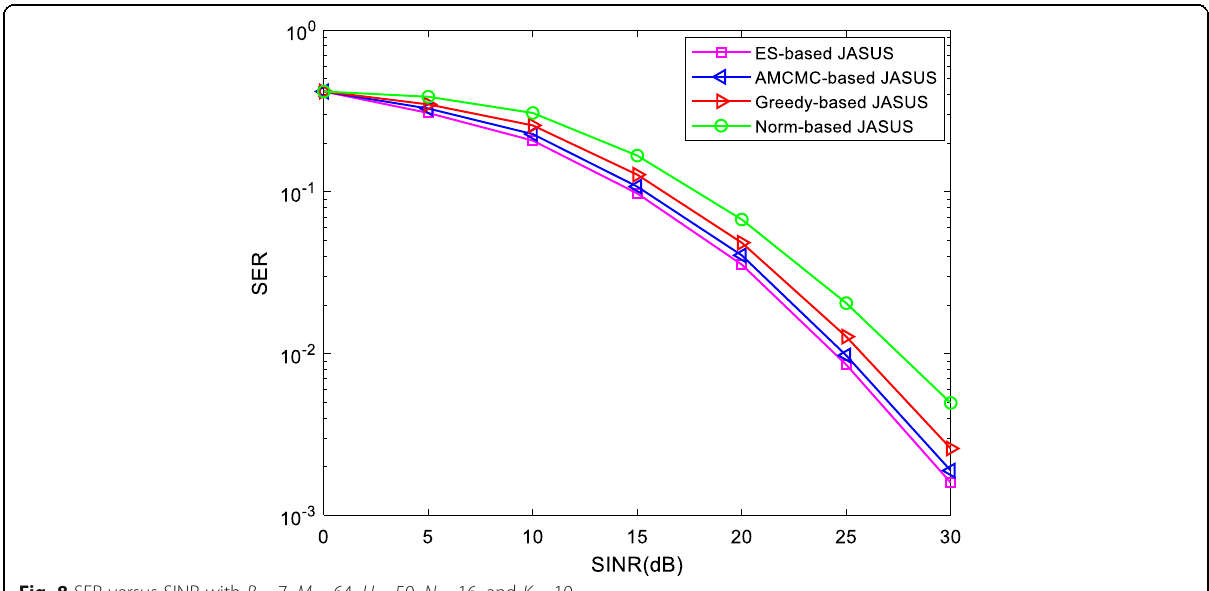
Fig. 8 SER versus SINR with B = 7, M = 64, U = 50, N = 16, and K =